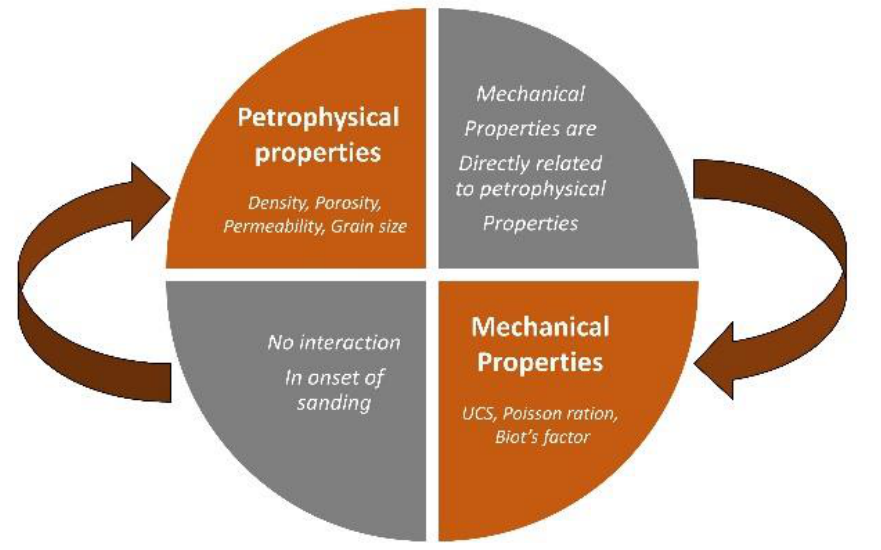
Figure 5. Interaction logic between two factors [54].